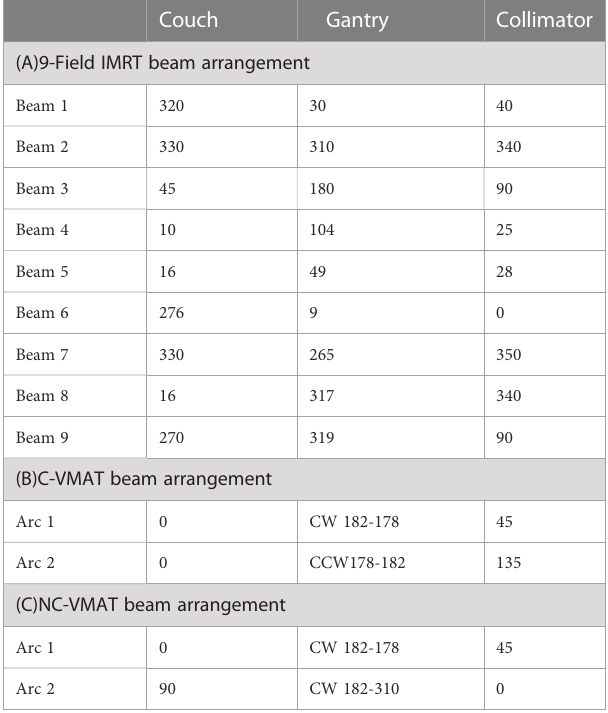
TABLE 2 9-Field IMRT, C-VMAT and NC- VMAT beam arrangements. Couch